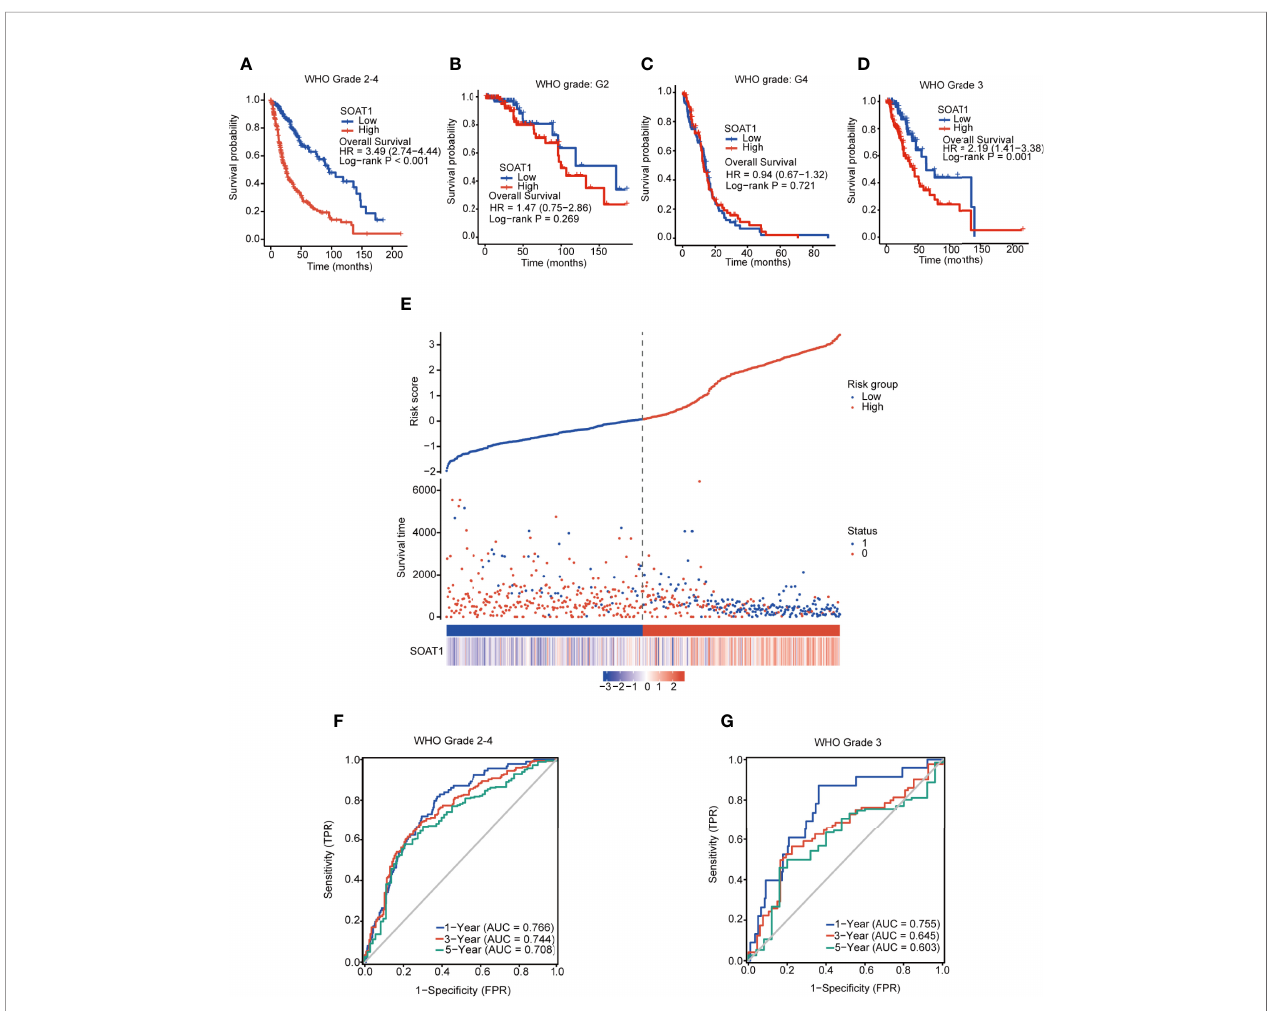
FIGURE 2 | SOAT1 expression was associated with poor prognosis in all diffuse gliomas of all grades taken together. (A – D) KM curves and log-rank tests of OS for SOAT1 in overall glioma, grade 2 glioma, GBM (grade 4), and grade 3 glioma, based on the TCGA cohort. (E) Prognostic risk score of OS for SOAT1 in overall glioma based on the TCGA cohort. (F, G) ROC curve of OS for SOAT1 in overall and grade 3 glioma, based on the TCGA cohort. SOAT1 , sterol O-acyltransferase 1 ; KM, Kaplan Meier; OS, overall survival; GBM, glioblastoma; TCGA, The Cancer Genome Atlas; ROC, receiver operating